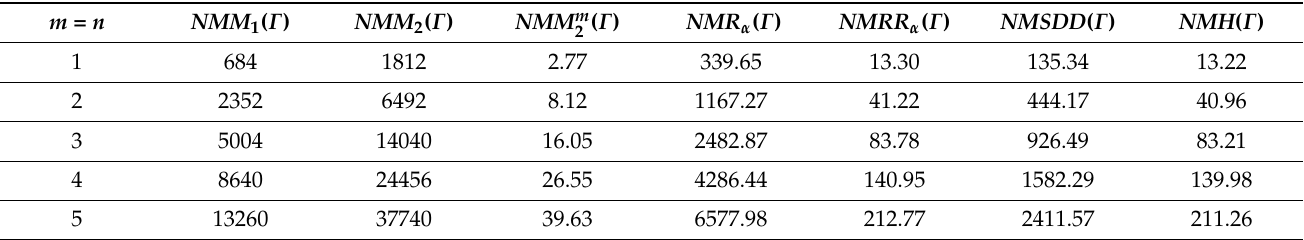
Figure 12. 3D plots for Table 11. Table 8. Comparison Table for Theorem 5.